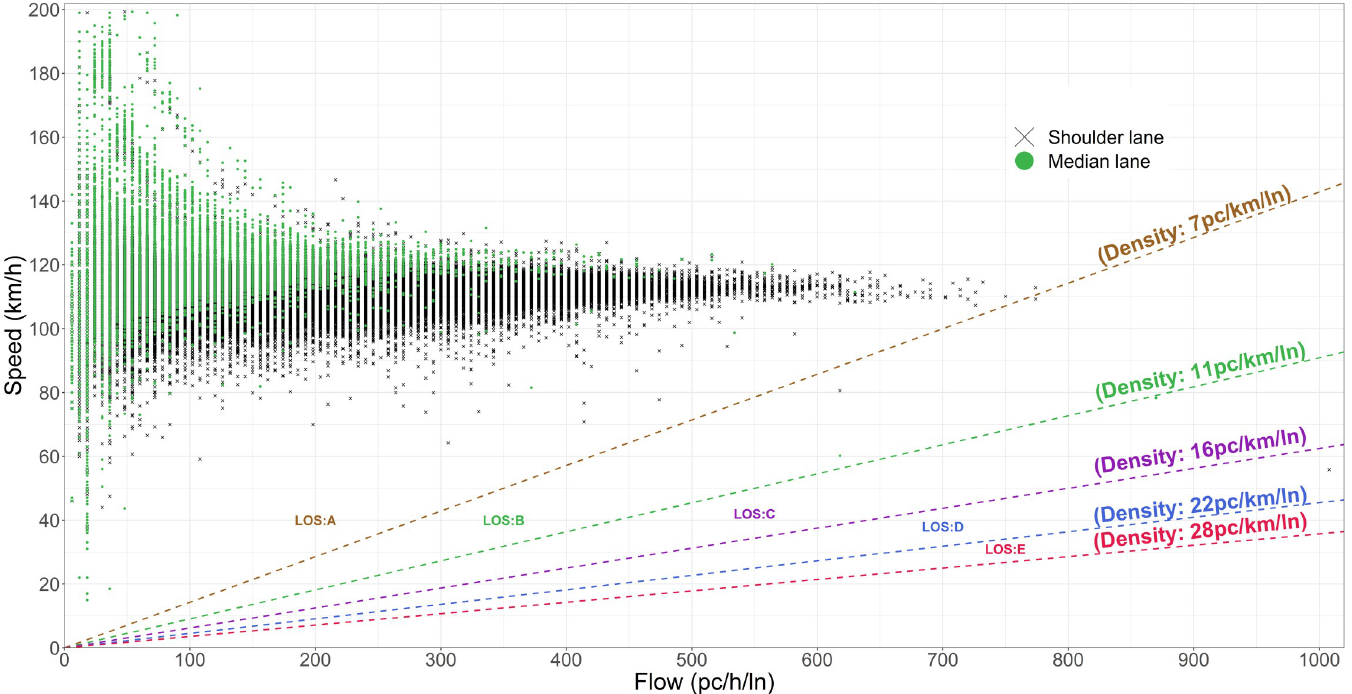
Fig 2. Speed-flow variation in the eastbound shoulder and median lanes at the study